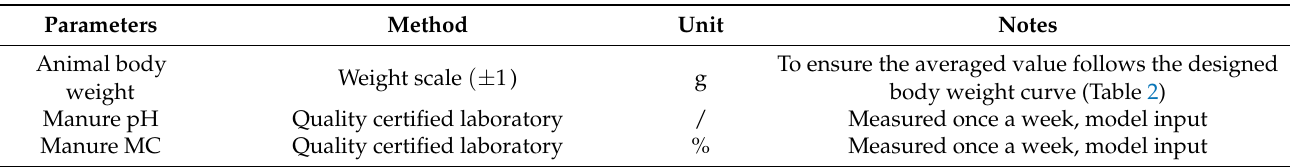
Table 8. Other parameters measured in the case study for model validation.